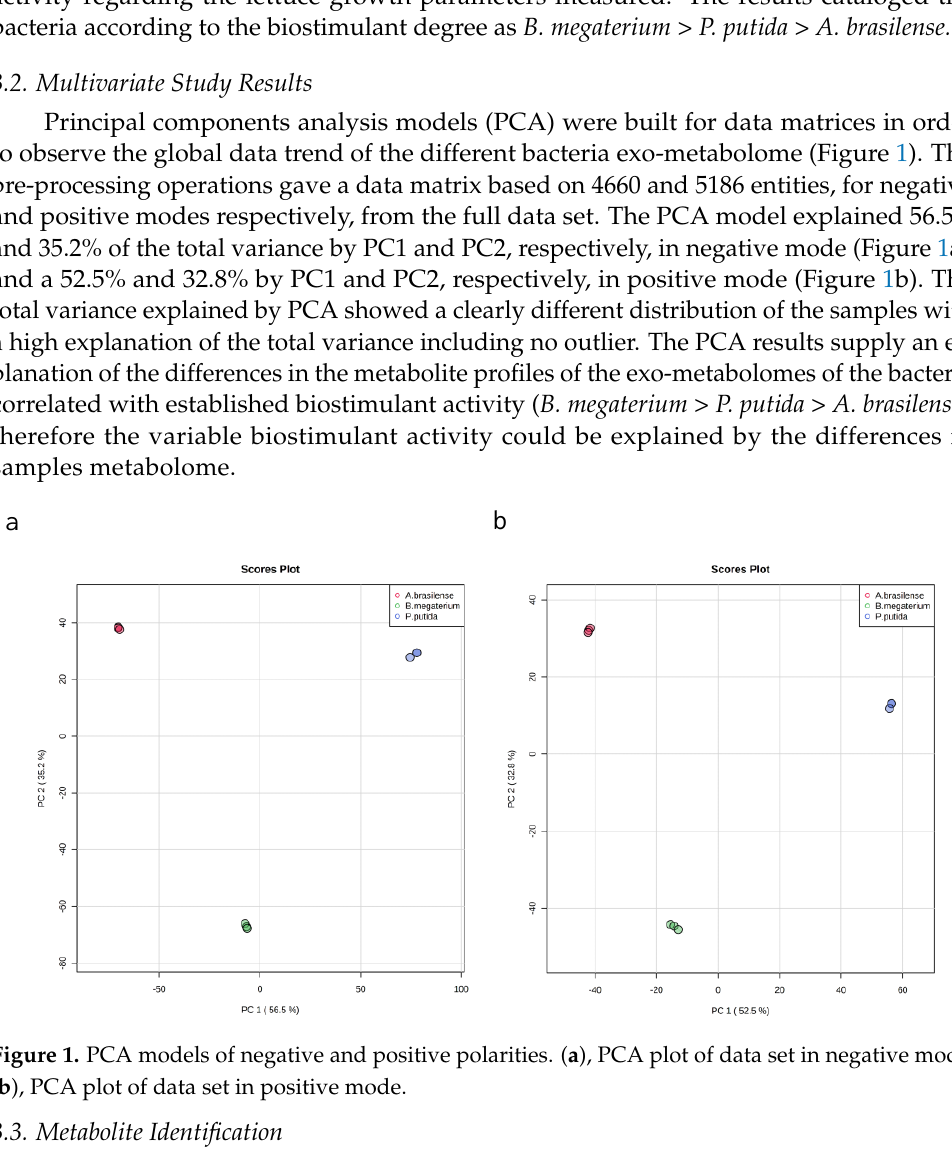
Table 3. Metabolites identified in the exo-metabolome of the bacteria. ID m/z